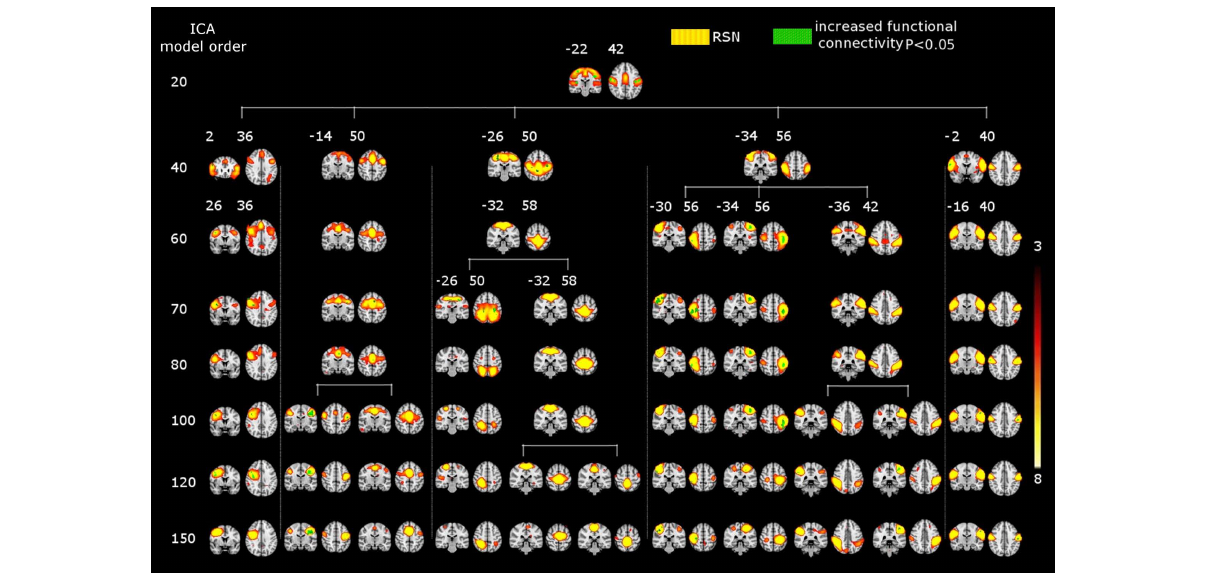
FIguRe 3 | SAD significant increased functional connectivity (green) in the motor cortex at different ICA model orders (20, 40, 60, 70, 80, 100, 120, and 150) shown superimposed on MNI template. One RSN (red– yellow) involving both the motor cortices and the auditory cortex as well at the low model order of 20. At higher model orders this large-scale RSN